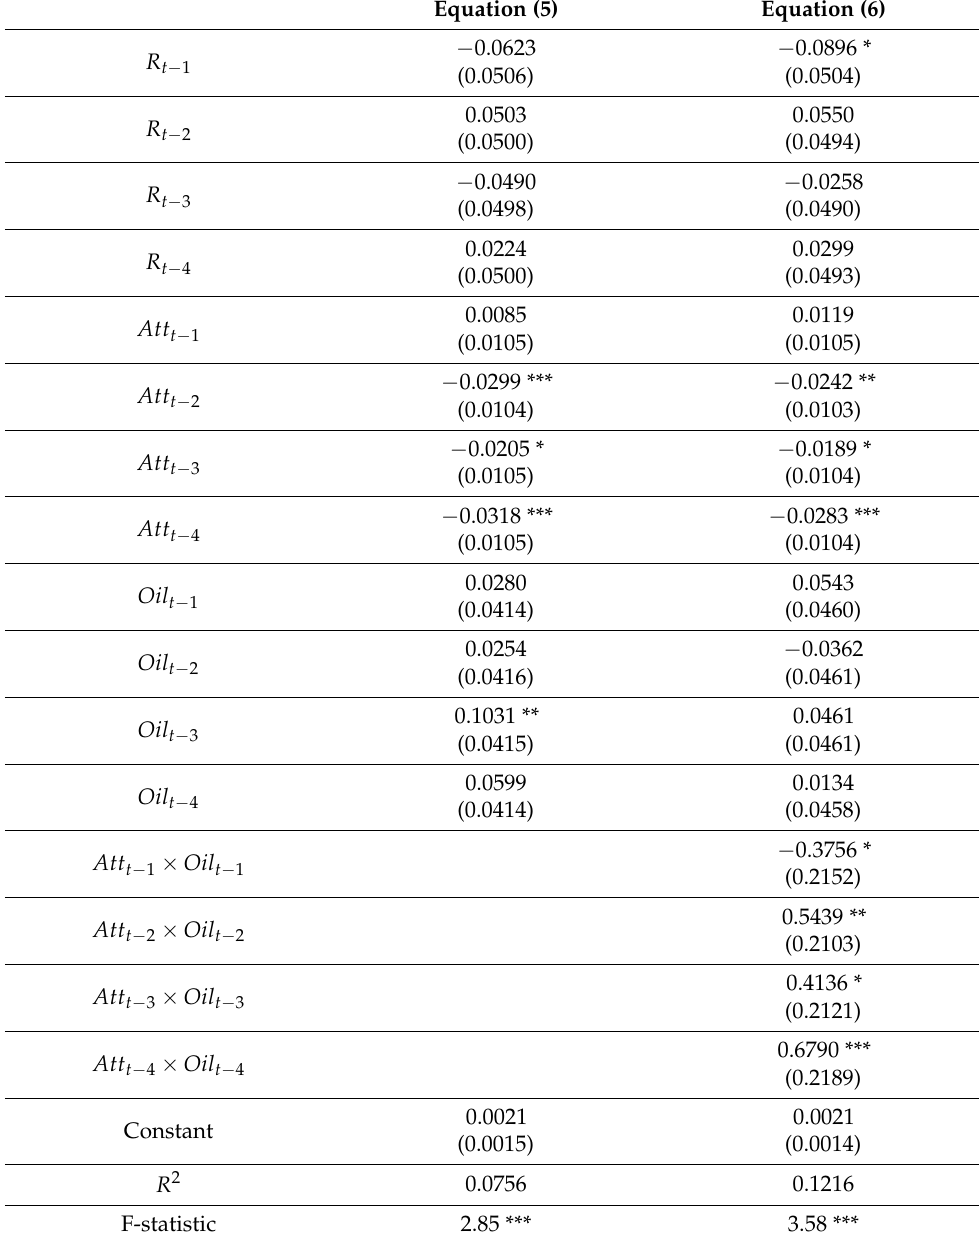
Table 6. Estimation after controlling the Brent oil market return.